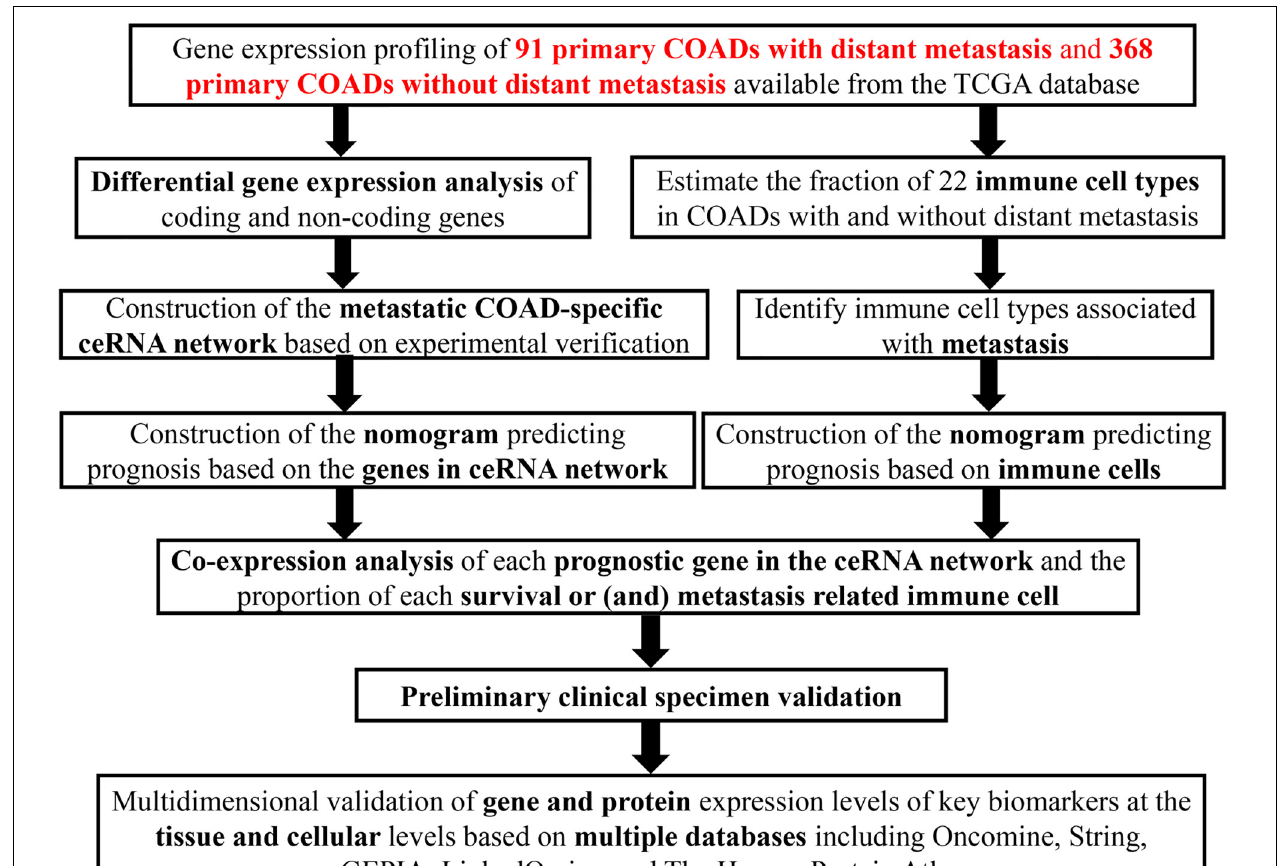
FIGURE 1 | The flow chart of the whole research